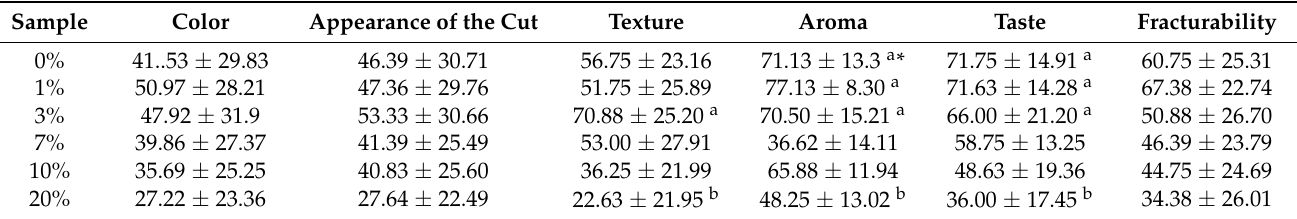
Table 5. Sensory